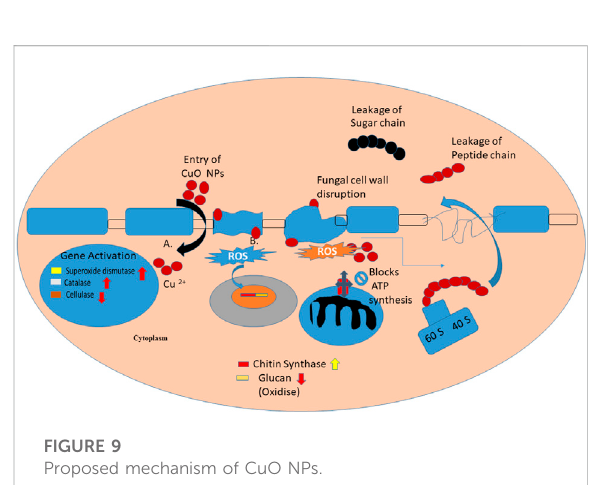
FIGURE 9 Proposed mechanism of CuO